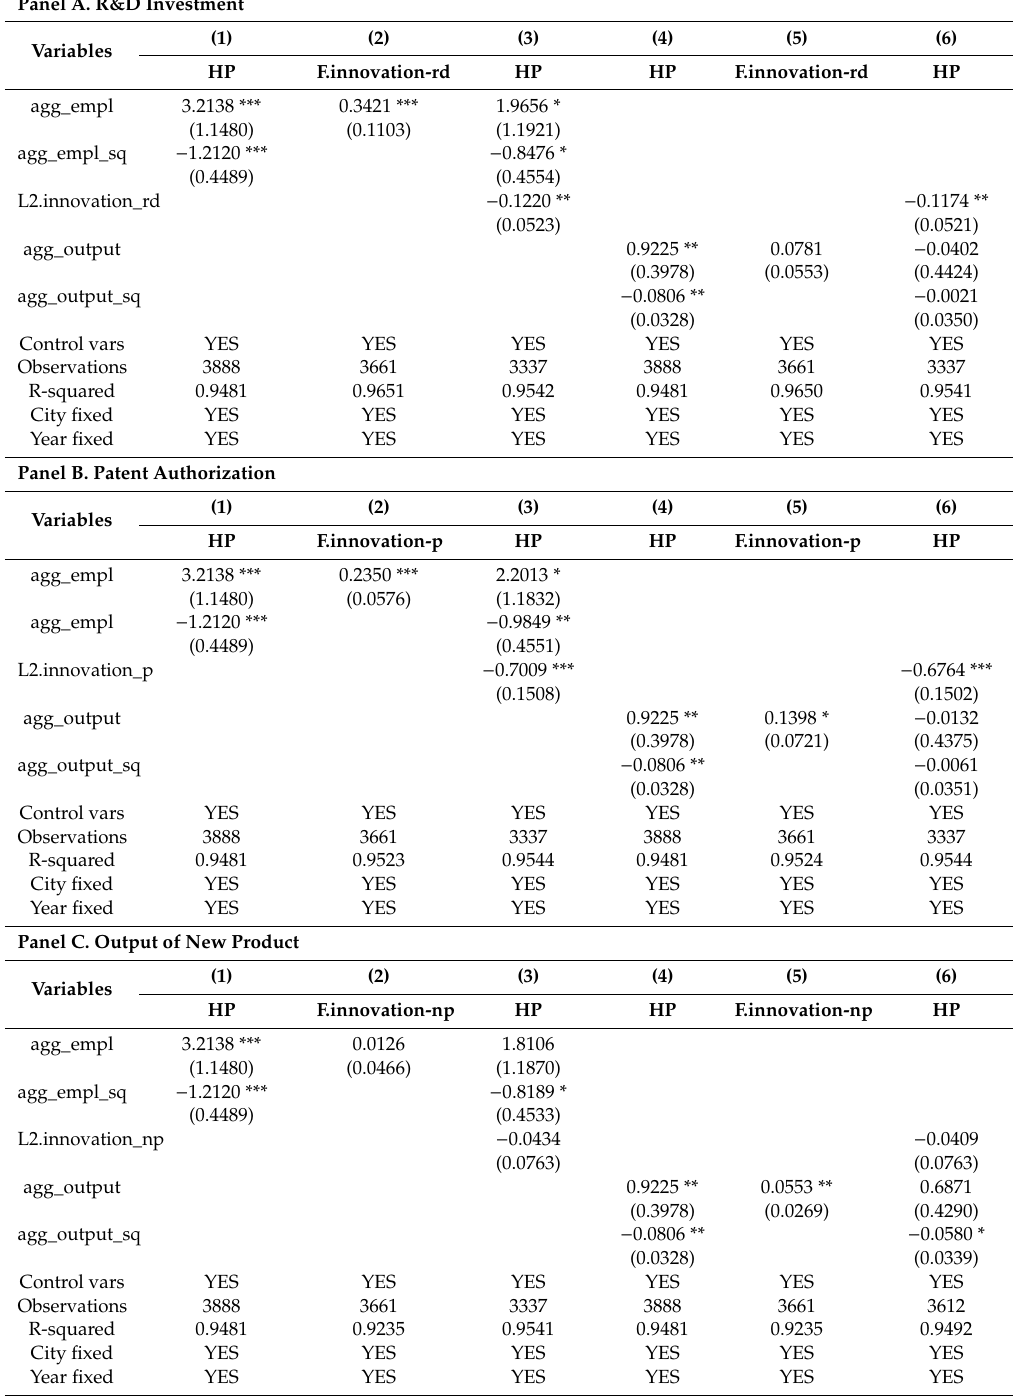
Table 8. Mechanism